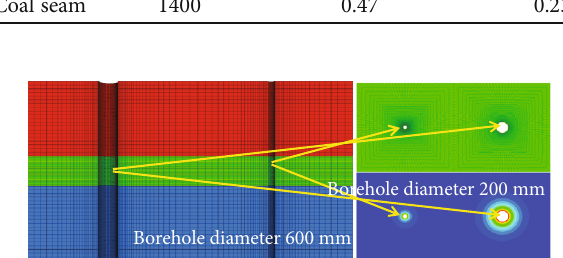
Figure 5: Geometric model of numerical